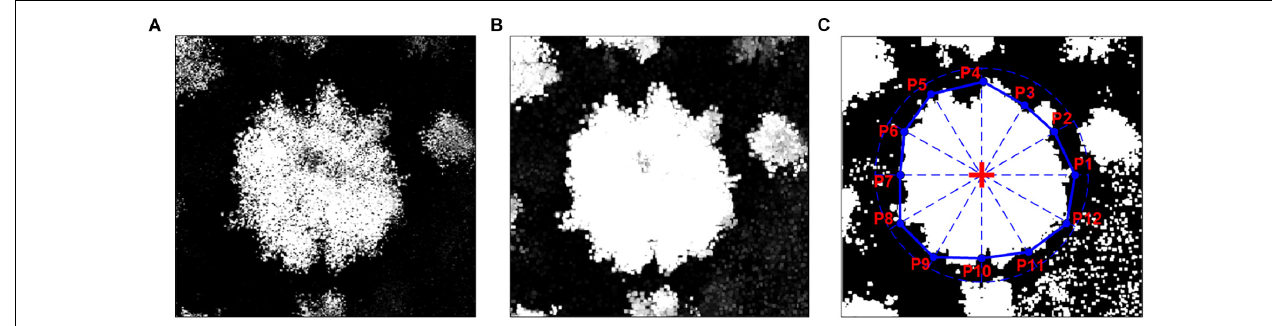
FIGURE 3 | Process of plant phenotyping parameter extraction. (A) The gridded plant height. (B) The spatially filtered plant height. (C) The binarization of plant height for identifying the location of plant canopy based on the central coordinates of plants (red + symbol) and the 2 m scanning line following the 30-degree interval, where the blue points (i.e., P1, P2, ... , to P12) are the location of intersection between plant canopy boundary and scanning